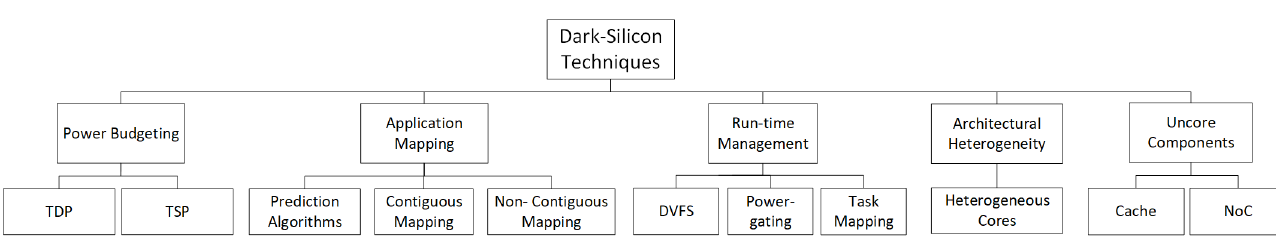
Figure 1. An Overview of Dark-Silicon Techniques